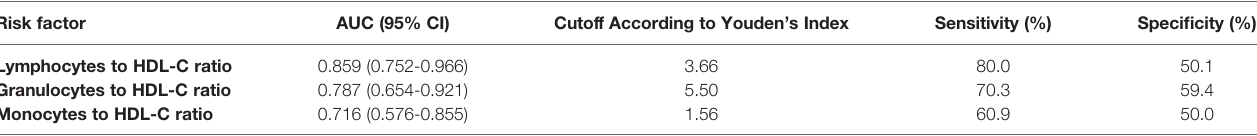
TABLE 6 | Areas Under the ROC Curve (AUC), Sensitivity and Speci fi city in predicting GDM. Risk factor